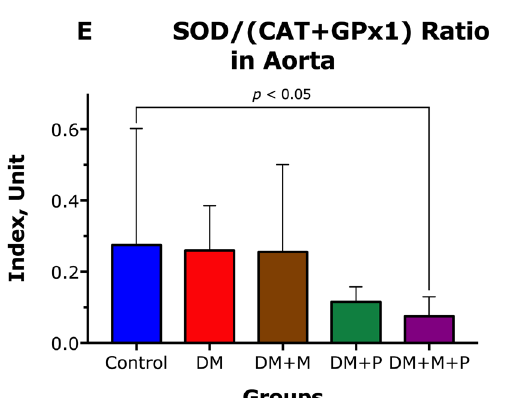
FIGURE 1 – The level of antioxidants in the aorta of experimental rats (n=8/group) comprising: A superoxide dismutase, B catalase, C glutathione peroxidase 1, D SOD/(CAT/GPx1) ratio, E soluble receptor for advanced glycation end-product. Data were presented as median (interquartile range) and analysed using Kruskal–Wallis H test with post hoc Bonferroni correction. CAT, catalase; DM, diabetes mellitus; GPx1, glutathione peroxidase 1; M, metformin; P, propolis; SOD, superoxide